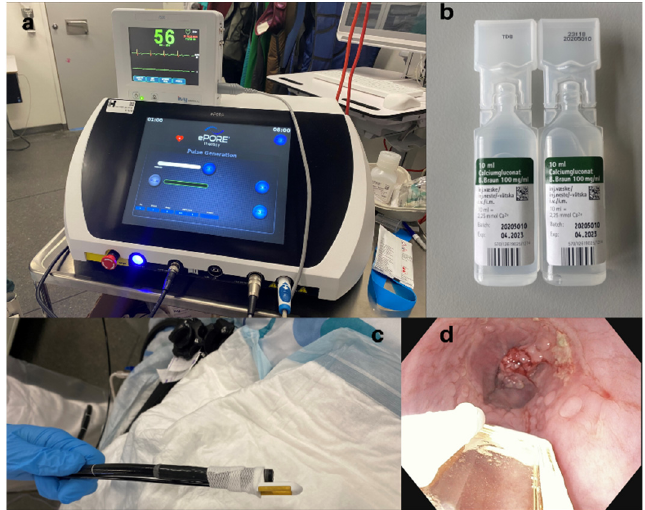
Figure 1. ( a ) The electroporator (ePORE ® ) is connected with a heart synchronization system. ( b ) Calcium gluconate. ( c ) The electrode (EndoVE ® ) is attached to the tip of the endoscope. ( d ) Calcium gluconate is injected into the tumor and the pulses are delivered. The procedure is repeated until the whole tumor area is covered.